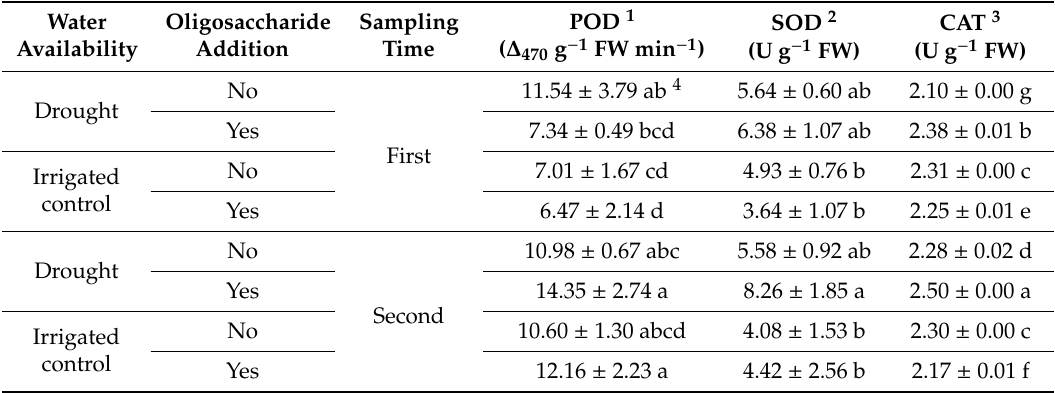
Table 2. Effects of sampling time, water availability, and oligosaccharide addition on anti-oxidation enzyme activity in Buddhist pine ( Podocarpus macrophyllus ) seedlings.